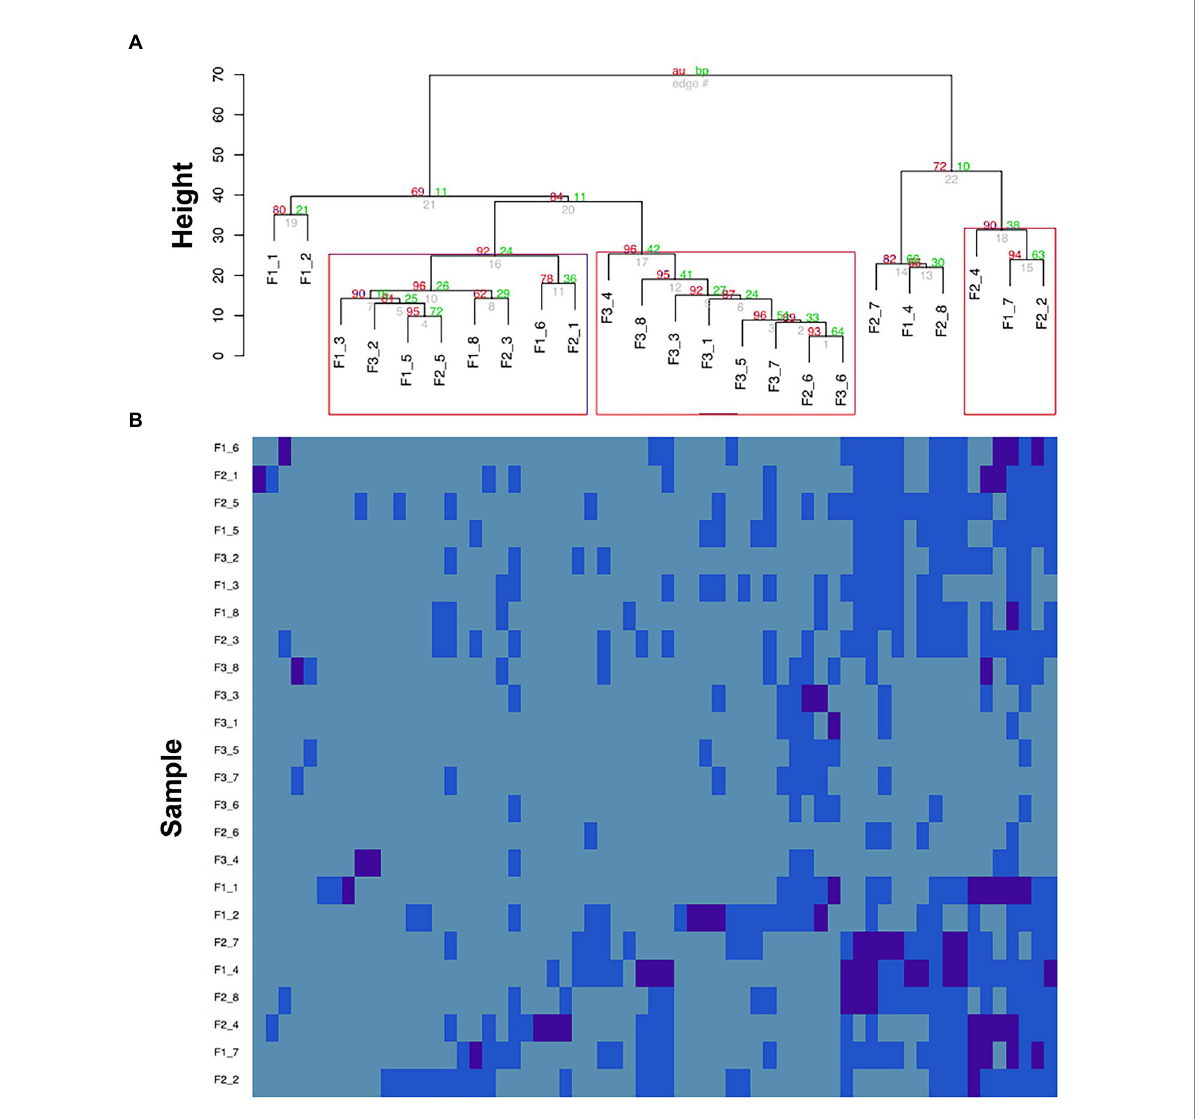
FIGURE 3 Temporal comparison of AMR-gene profiles (modified from a figure in Urbaniak et al., 2018). (A) Hierarchical clustering of the AMR-genes. Red values are AU (Approximately Unbiased) p -values, and green values are Bootstrap probability values. Clusters with AU p-values larger than 90% are highlighted by rectangles, meaning that there is a 90% certainty of these clusters being a distinct group. F“x” refers to the flight number, followed by the location. (B) Heatmap of centered log ratio transformed gene expression data. Deep blue boxes represent samples that have higher gene expression then the geometric mean expression (light blue), which has been calculated from all samples, which has been calculated from all